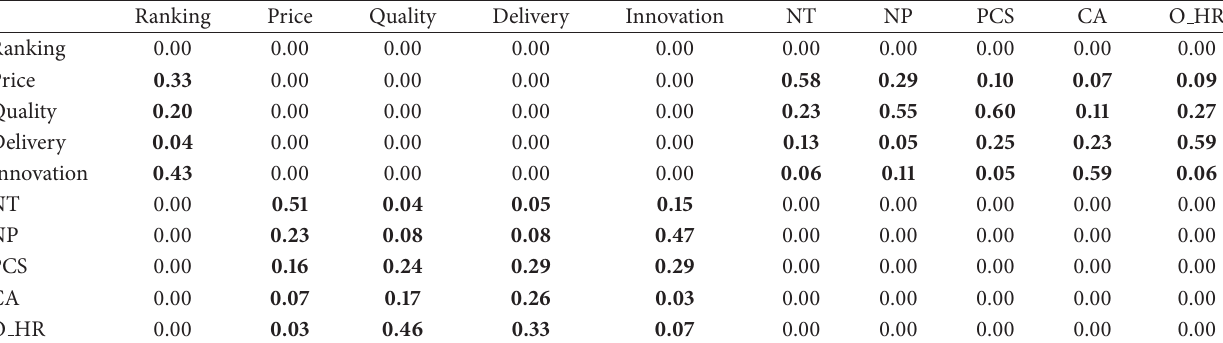
Table 4: Normalized supermatrix of decision agent 1.